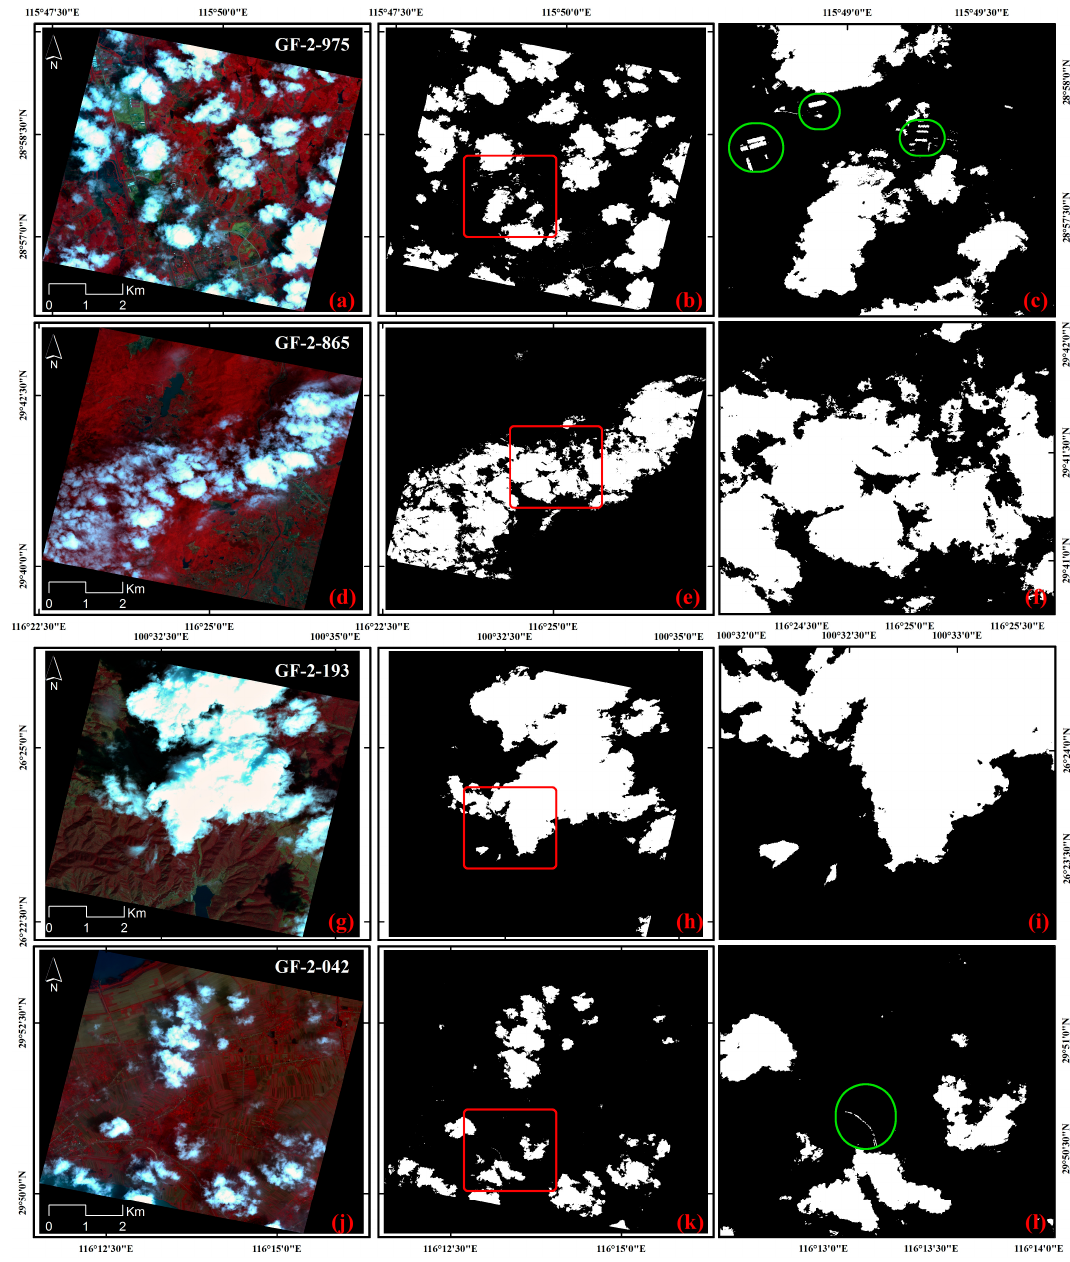
Figure 6. The origin map and classification results of four selected GF-2 images: ( a – c ) the original map, cloud classification map, and the magnified area corresponds to the red line regions of cloud classification map for GF-2-975, respectively; ( d – f ) for GF-2-865; ( g – i ) for GF-2-193; ( j – l ) for GF-2-042. The white regions in the classification results represent our cloud detection results. The green frame refers to cloud detection misjudgments.